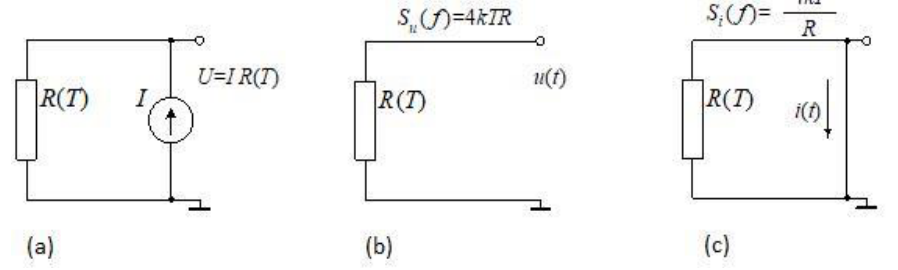
Figure 1. ( a ) Resistor thermometer; the R ( T ) function and R value must be known and a biasing DC current I that, by unavoidably heating the thermometer causes error, is needed; ( b ) the usual Johnson-noise thermometry: S U is the power spectral density of the voltage fluctuations across the resistor, k is the Boltzmann constant, and T is the absolute temperature. Differently from the resistor thermometer, the R ( T ) function is not needed but the resistance value R must be known; ( c ) fluctuation-enhanced absolute thermometry based on Johnson noise and first principles: the Johnson voltage and current noise are measured (circuits b and c ). The combination of the two measurements provides both the absolute temperature T and the resistance R . No heating occurs and no preliminary knowledge is needed if accurate current and voltage noise measurement systems are available.